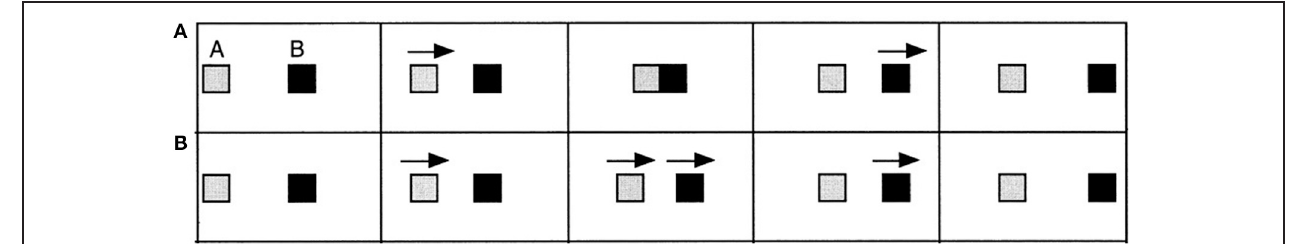
FIGURE 1 | Michotte’s (1963) launch event (top—A) and Kanizsa and Vicario’s reaction event (bottom—B).